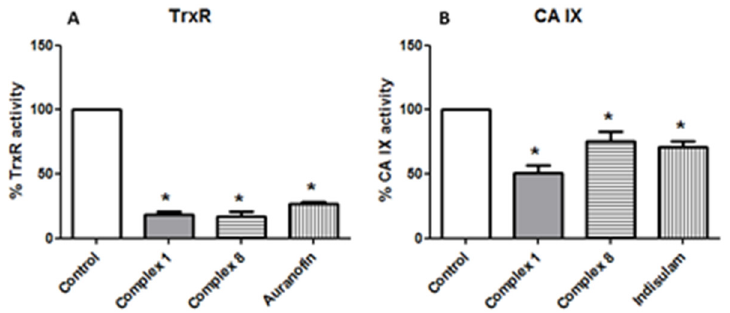
Figure 6. ( A ) Determination of the reductase activity of recombinant TrxR1 after in vitro incubation